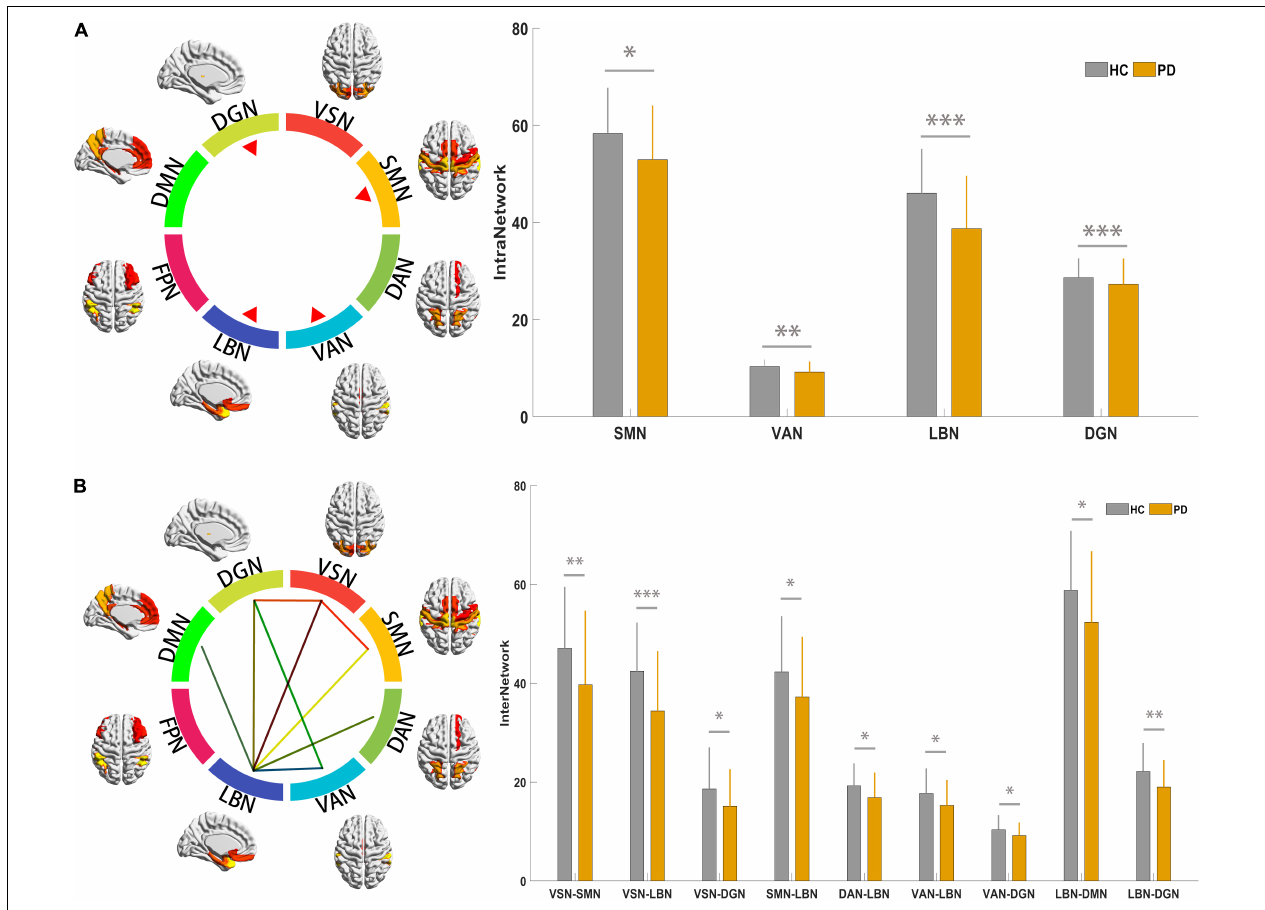
FIGURE 2 | Results for connectivity among the 9 RSNs at the intra- and inter-network. (A) The colorful circle indicates the composite of 9 RSNs. The 4 red triangles indicate that the RSNs showed altered intra-network connections based on results indicating statistical significance. The histogram compares the 4 networks between PD and HC groups; the y-axis represents intra-network functional connectivity strength. (B) The colorful circle indicates the composite of 9 RSNs. The line linking 2 RSNs indicates altered individual inter-network connections based on statistically significant results. The histogram compares significantly decreased inter-network connections between the PD and HC groups; the y-axis represents the inter-network functional connectivity strength. Asterisks indicate significant group differences ( ∗ p < 0.05; ∗∗ p < 0.01, ∗∗∗ p < 0.001). PD, Parkinson’s disease; HC, healthy control; RSNs, resting-state network; VSN, the visual network; SMN, somatomotor network; DAN, dorsal attention network; VAN, ventral attention network; LBN, limbic network; FPN, frontoparietal network; DMN, default mode network; DGN, deep gray matter